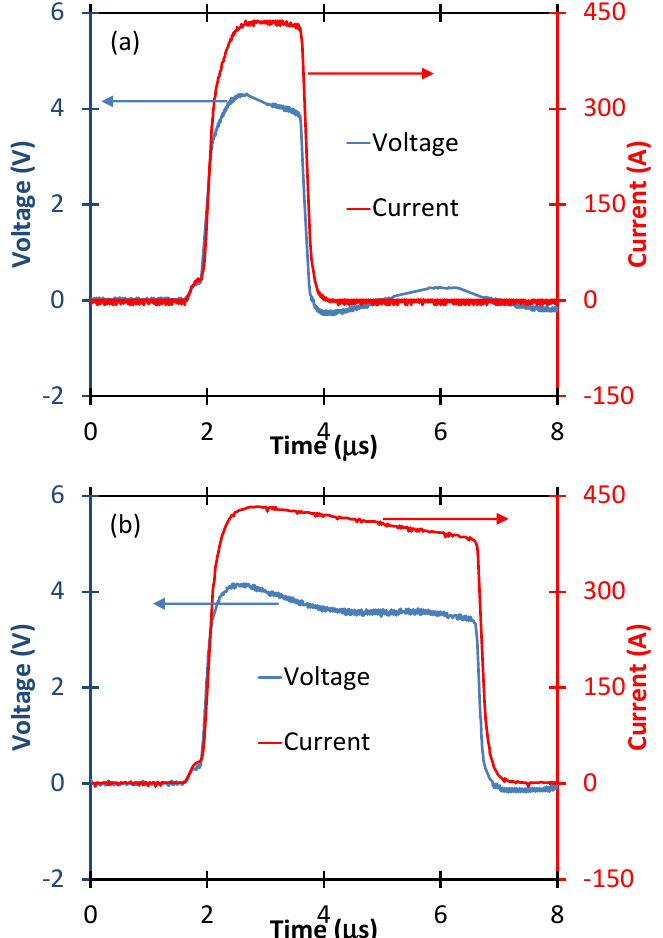
Figure 1. Representative voltage and current waveforms for pulsed electric field conditions ( a ) peak voltage ~4.3 kV and pulse duration 2 µs (PEF A) and ( b ) peak voltage ~3.5 kV and pulse duration 5 µs (PEF F). Electric stimulation of PRP used a single electric pulse.